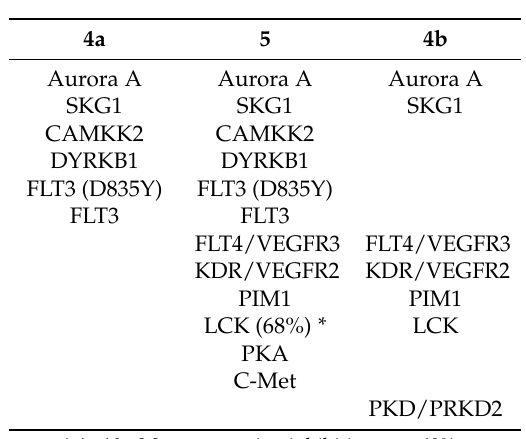
Table 1. Selectivity profile of dibenzofuran derivatives: human kinases that were inhibited more than 70% at 10 µ M